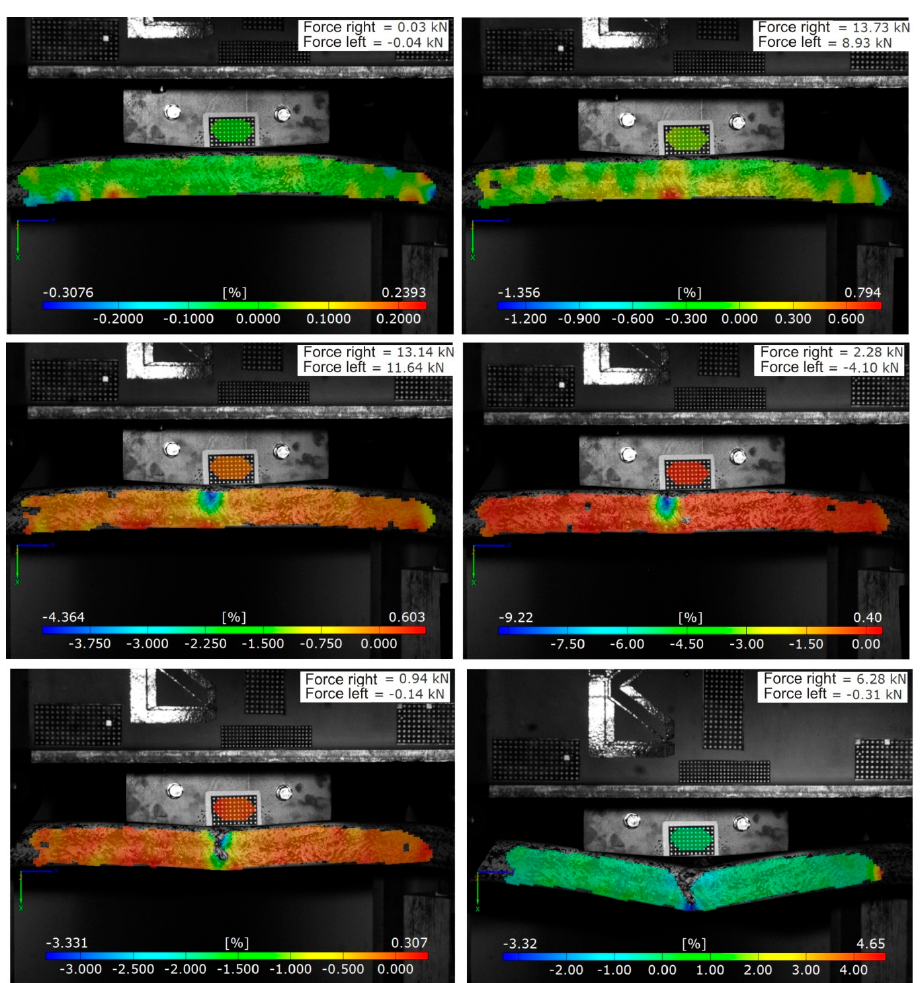
Figure 4. Deformation characteristics of bumper bracket configuration ( a ), layup: 4 layers ±45° with 0° filler yarn (2D triaxial braid), during a drop tower test with m imp = 435 kg and v imp = 8 km/h.